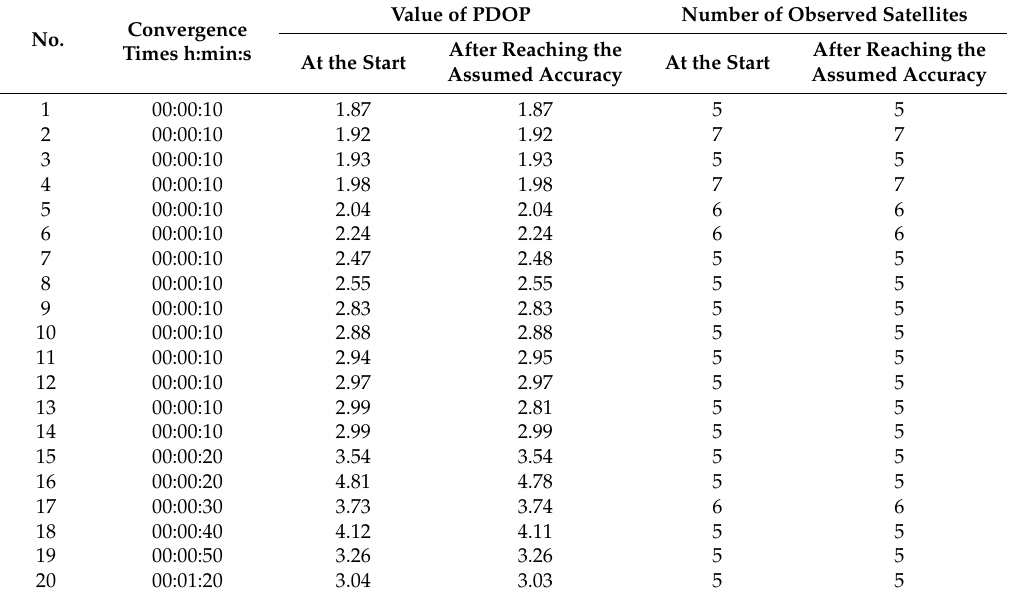
Table 8. The list of obtained convergence